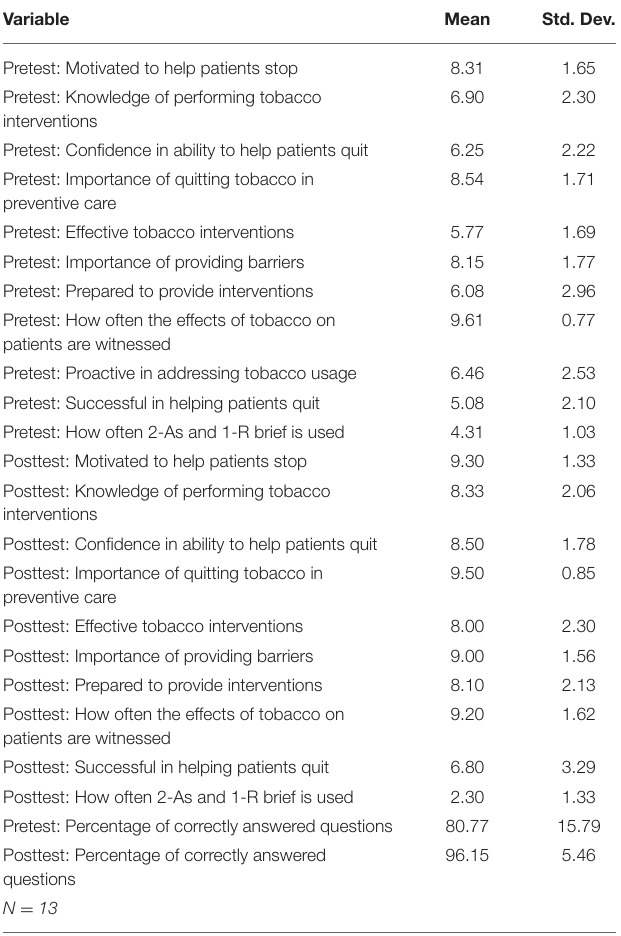
TABLE 1 | Means and standard deviations: focal variables. Variable Mean Std.